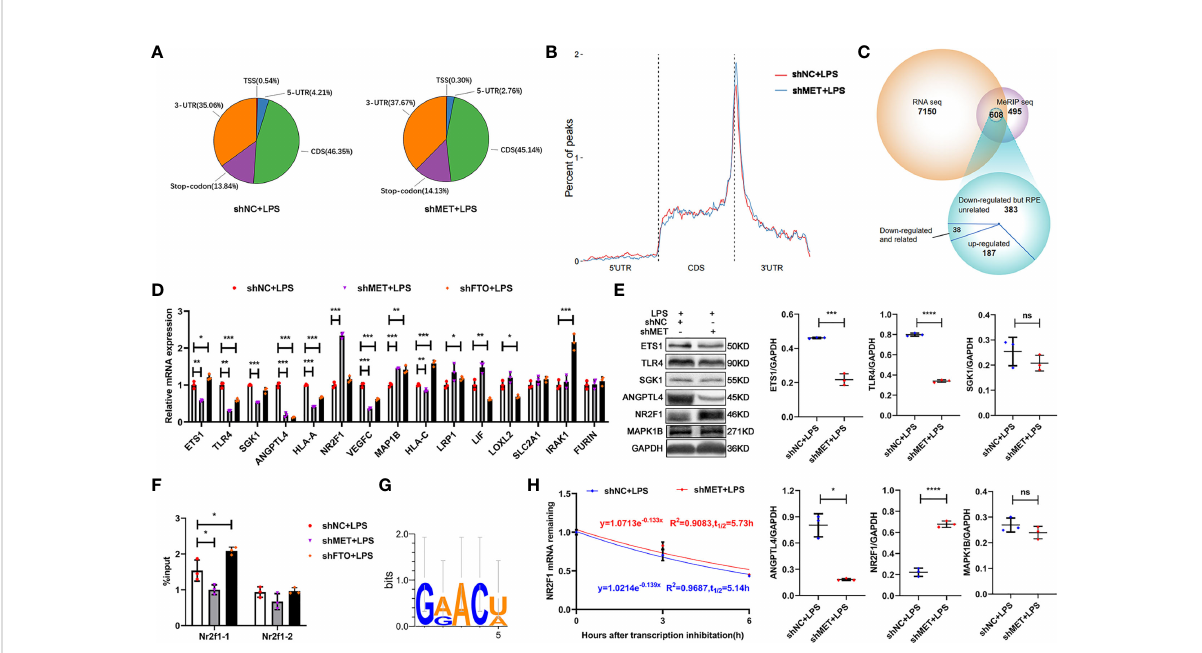
FIGURE 4 METTL3 inhibits NR2F1 in an m6A-dependent manner. (A) Pie charts represent the percent of all m 6 A peaks on mRNA (CDS, coding sequence; UTR, untranslated region; TSS, transcription start site). (B) The percent of m 6 A peaks on three segments of mRNA: 5´UTR, CDS and 3´UTR. (C) Venn diagram of MeRIP-seq and RNA-seq to identify common differentially expressed genes (DEG). (D) mRNA levels of ETS1, TLR4, SGK1, ANGPTL4, HLA-A, NR2F1, VEGFC, MAP1B, HLA-C, LRP1, LIF, LOXL2, SLC2A1, IRAK1 and FURIN in the METTL3- or FTO-silenced ARPE19 cells after LPS stimulation (mean ± SD; * P<0.05, ** P<0.01, *** P<0.001; n=3/group; one-way ANOVA). (E) Protein levels of ETS1, TLR4, SGK1, ANGPTL4, NR2F1 and MAP1B in the METTL3-silenced ARPE19 cells after LPS stimulation. Left, representative western blotting images of these proteins. Right, quanti fi cation of relative expression (mean ± SD; ns P>0.05, * P<0.05, *** P<0.001, **** P<0.0001; n=3/group; unpaired Student ’ s t-test). (F) Site-speci fi c mRNA levels of NR2F1 after m 6 A immunoprecipitation in the METTL3- or FTO-silenced ARPE19 cells (mean ± SD; * P<0.05; n=3/group; one-way ANOVA). (G) NR2F1 binding motif identify. (H) The half-life detection of NR2F1 in the METTL3-silenced ARPE19 cells after LPS stimulation (mean ± SD;